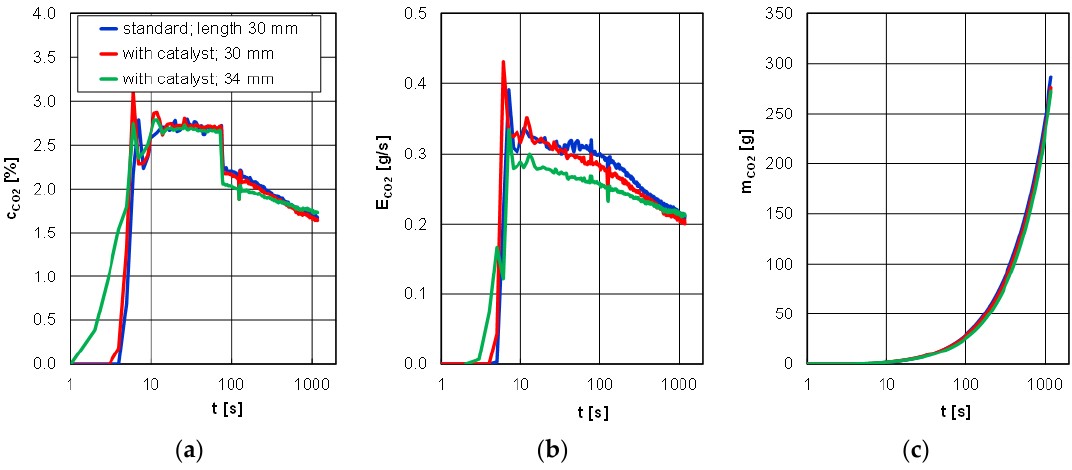
Figure 12. Concentration ( a ), emission rate ( b ), and emission of carbon dioxide ( c ) during the tests of a diesel engine depending on the type of glow plugs and the length of the catalyst-covered ones.